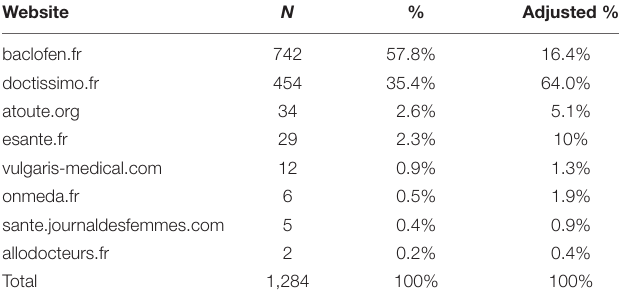
TABLE 3 | Validated posts